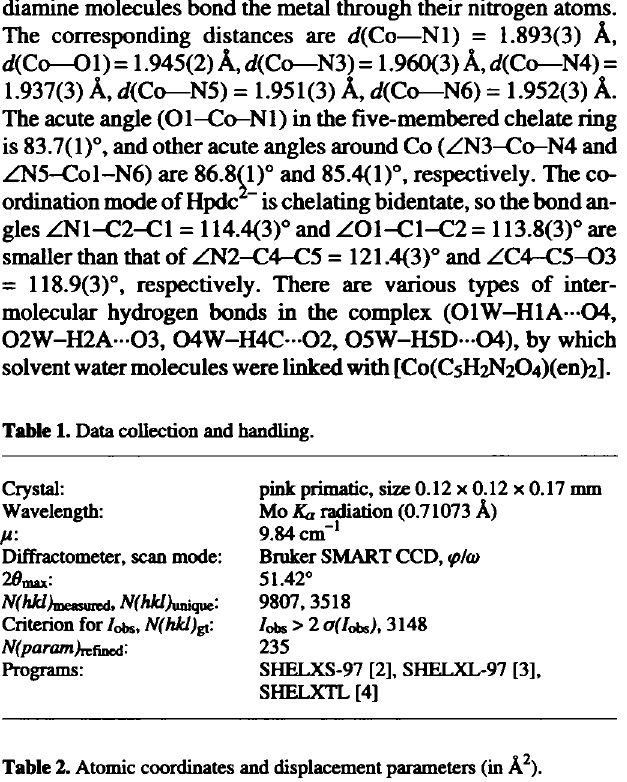
Table 2. Atomic coordinates and displacement parameters (in Â 2